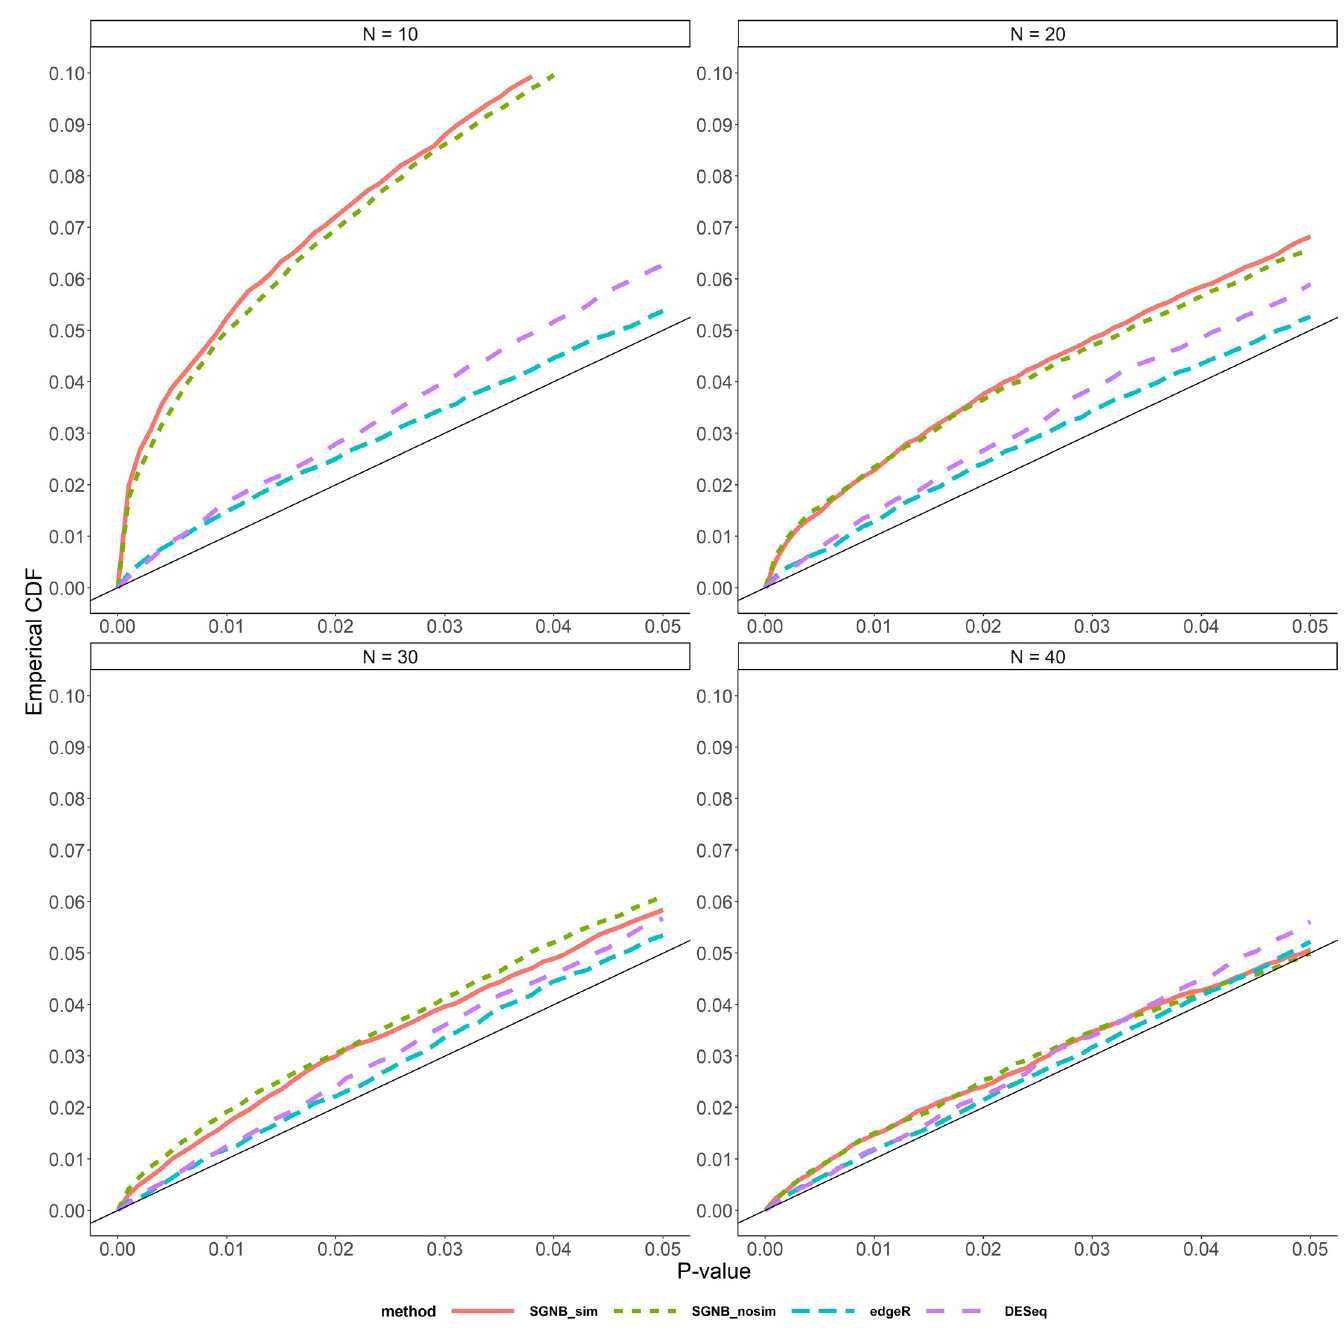
Fig 4. Type I error control with large dispersion by P-value <